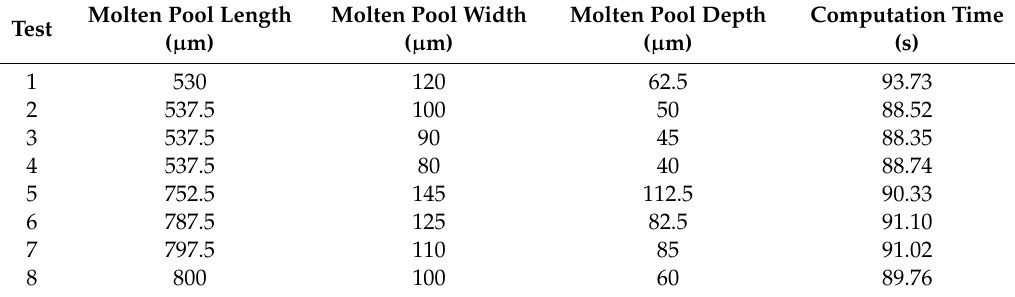
Table A2. Predicted molten pool